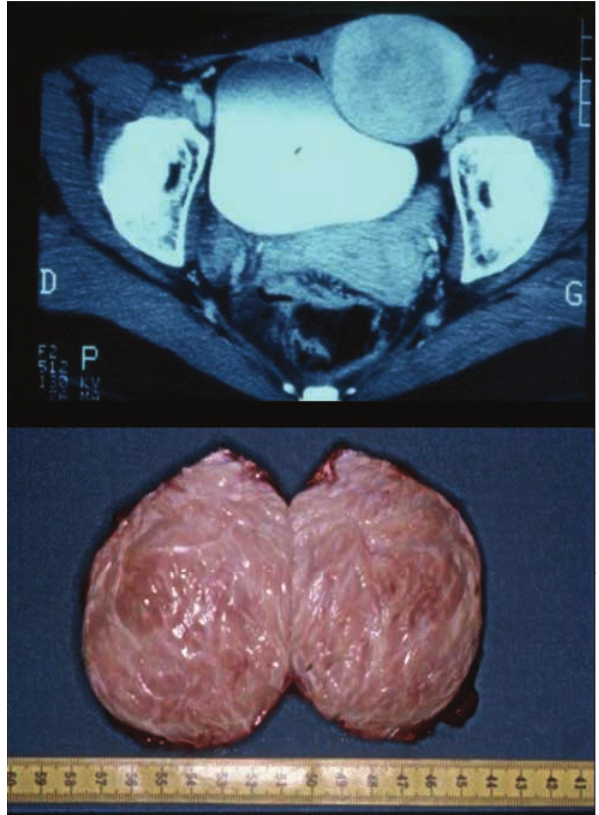
Figure 1. A: Desmoid tumor that arose after total colectomy in the anterior abdominal wall in a young FAP-affected female patient: CT